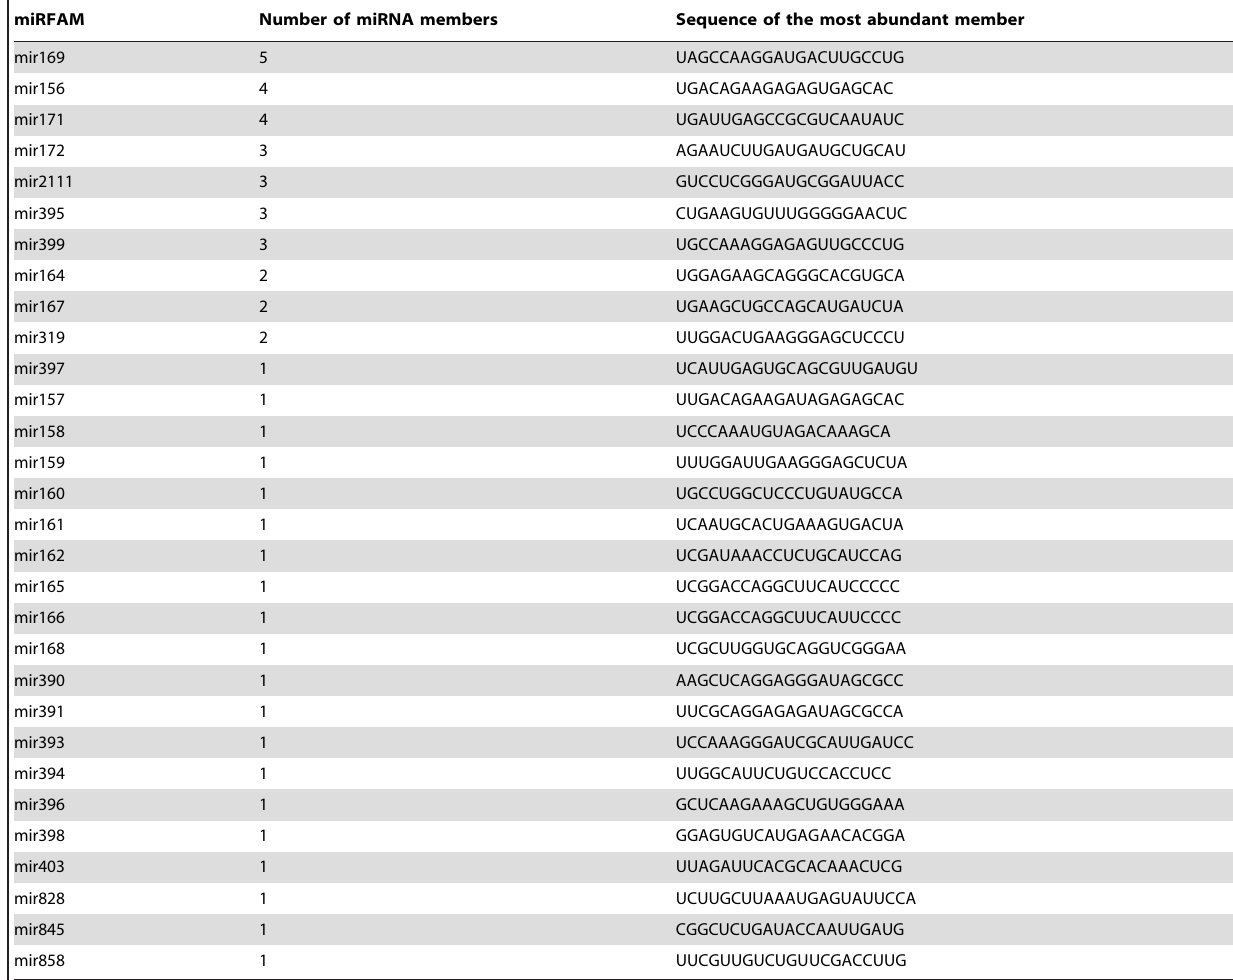
Table 2. Family wise distribution of conserved miRNAs in B. juncea .